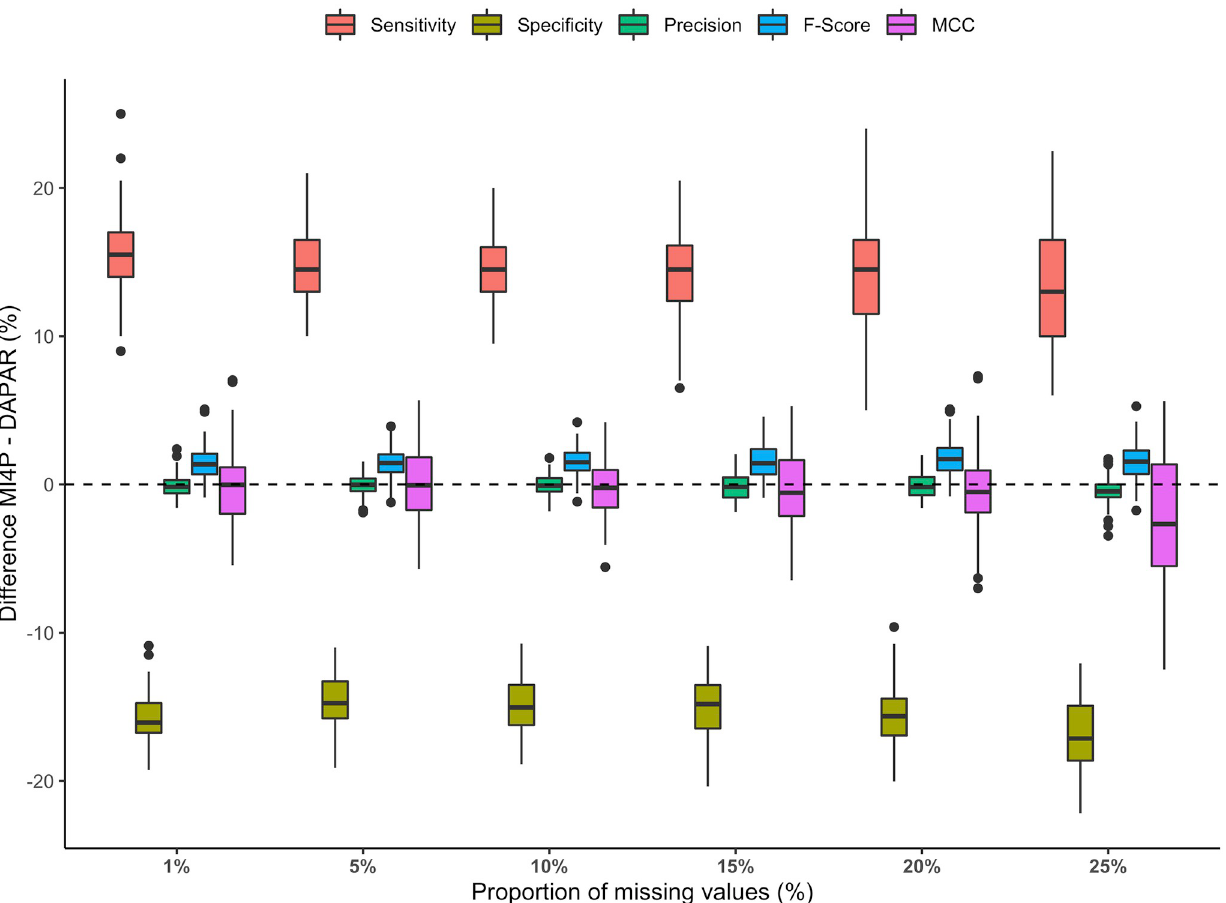
Fig 10. Distributions of differences in sensitivity, specificity, precision, F -score and Matthews correlation coefficient for the first MCAR + MNAR set of simulations. Missing values were imputed using the maximum likelihood estimation method.